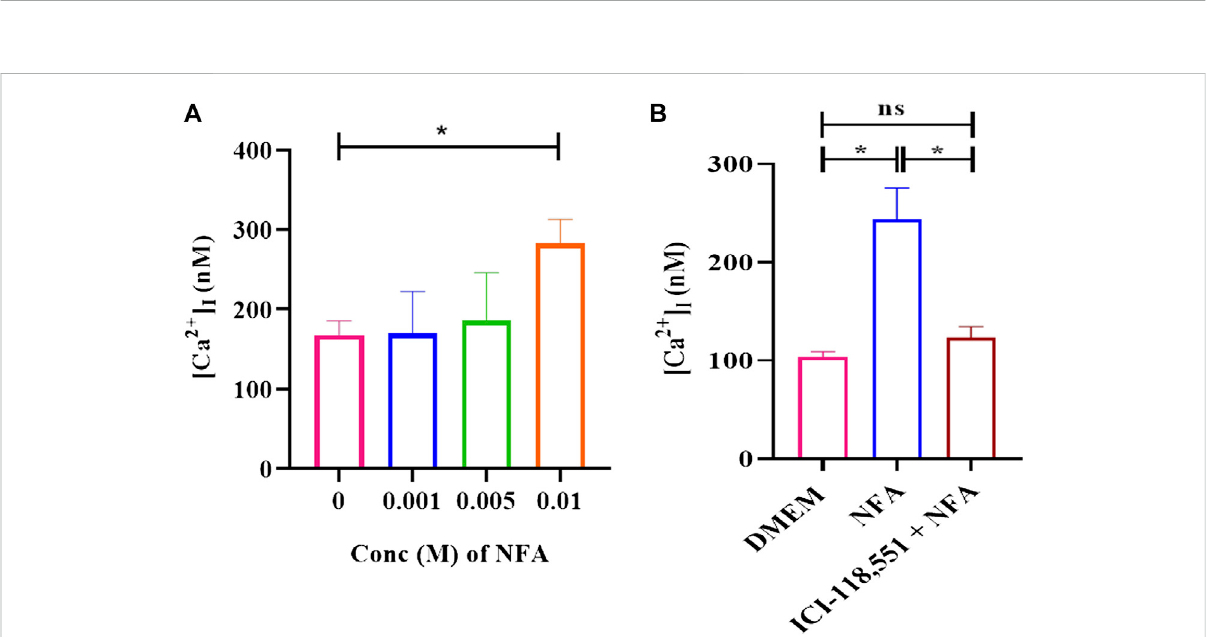
FIGURE 4 NFA increases [Ca 2+ ] I levels in capacitating sperm. [Ca 2+ ] I was assessed on exposure of capacitating sperm to 0.001, 0.005, and 0.01 M NFA using Fura-2 AM-based assay. Fura-2AM-loaded capacitating sperm were stimulated with the stated concentrations of NFA and the corresponding F-max and F-min values were recorded after the addition of 1% Triton X-100. Excitation of the dye with bound and unbound calcium was measured at 340 and 380 nm, respectively, and fl uorescence emission at 500 nm. The fi gure shows a graph of [Ca 2+ ] I at different concentrations of NFA (A) . The effect of the β -2-AR antagonist on [Ca 2+ ] I was studied after 30 min exposure of capacitating sperm to 0.01 μ M ICI-118,551 before exposing them to 0.01 M NFA (B) . The results presented are cumulative from three experiments. Values are expressed as mean ± SEM. *p <